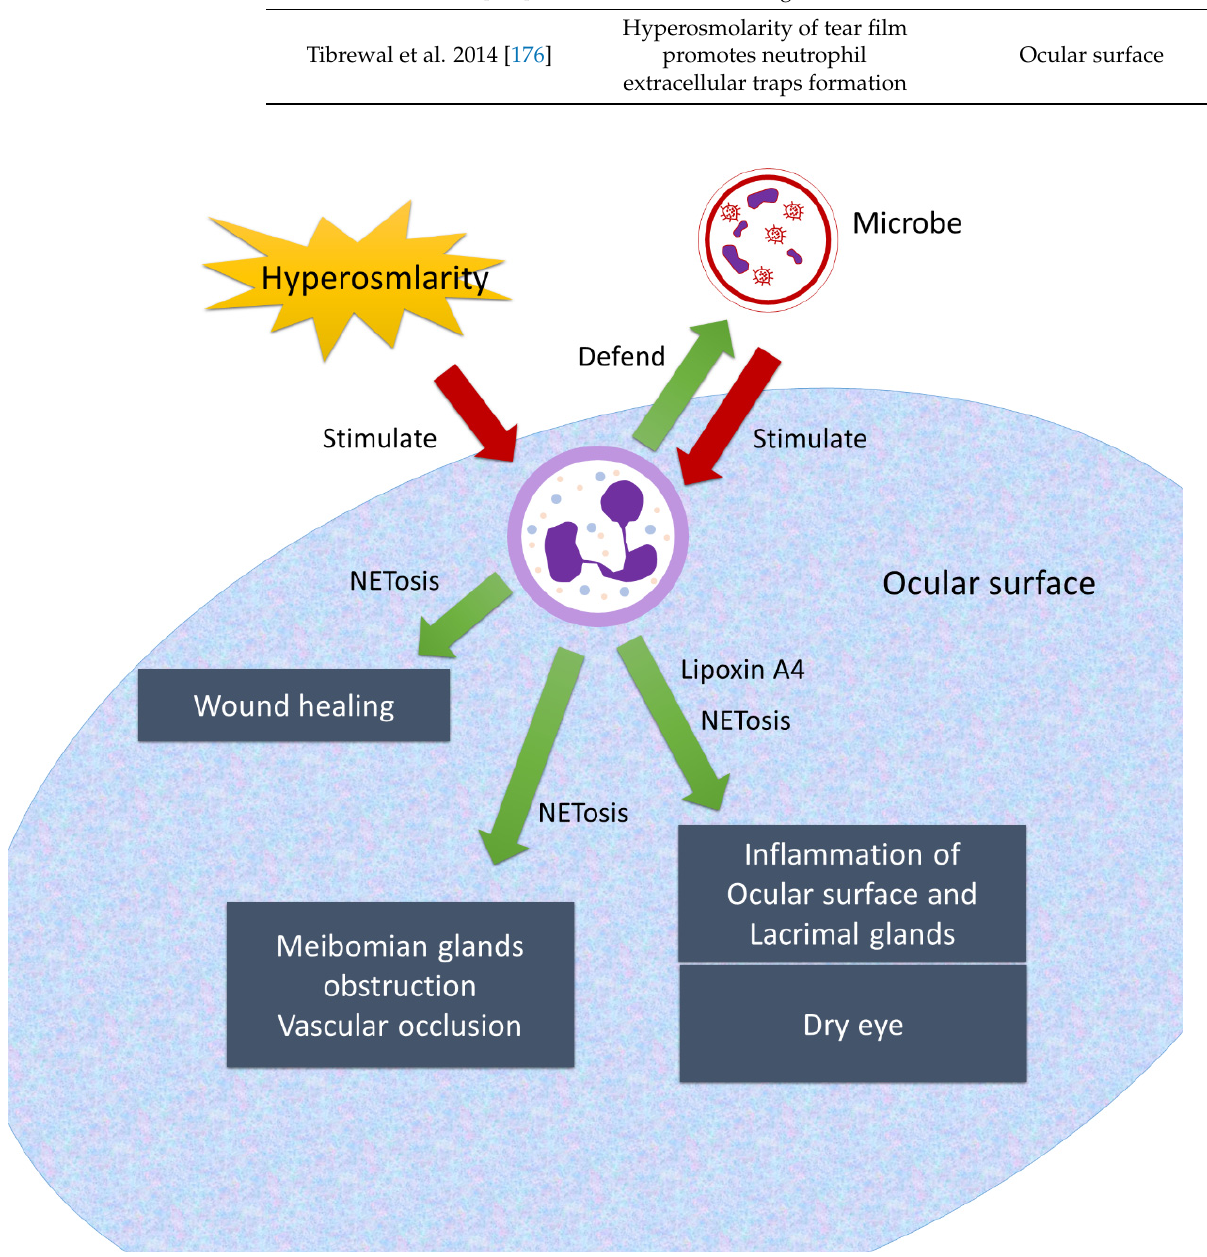
Figure 3. Neutrophils on the ocular surface.